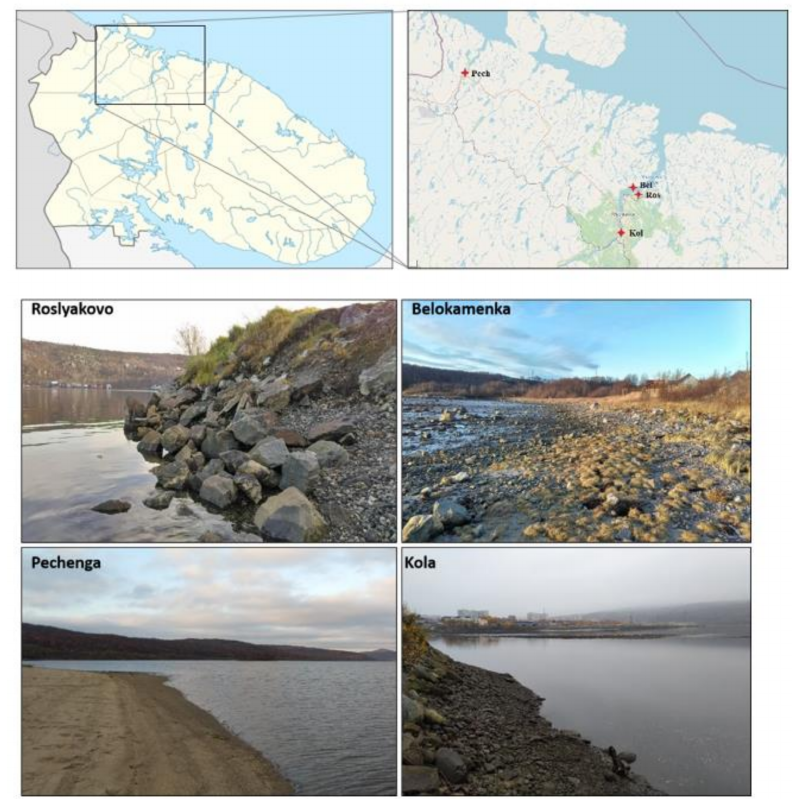
Figure 1. Sampling